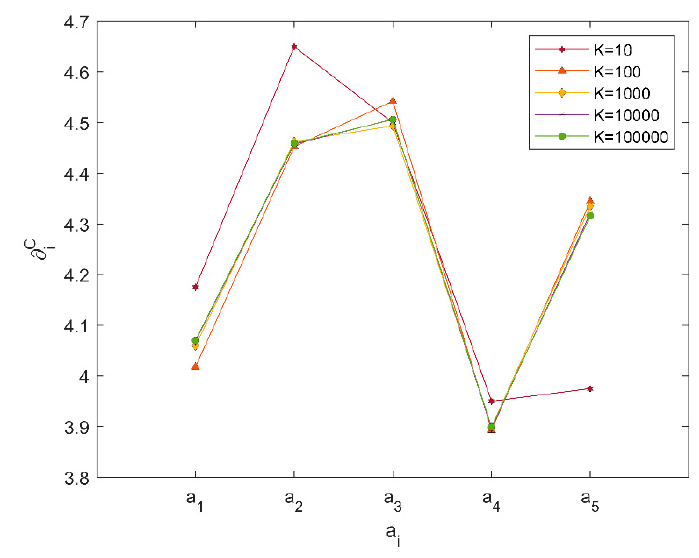
Figure 4. Total ranking results based on different parameter K .